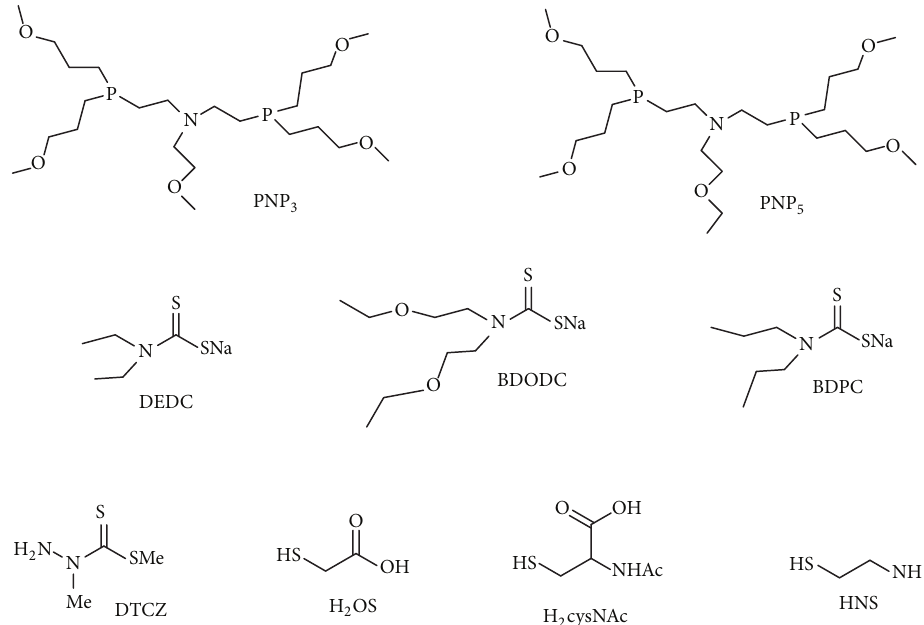
Figure 10: Chemical structure of PNP, L, and B ligands